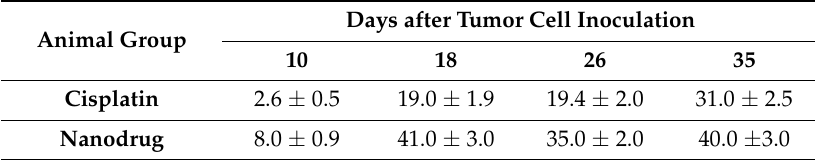
Figure 5. The changes of tumor volume in the standard and nanodrug receiver groups compared to the control group. Statistical significance: * p < 0.05, ** p < 0.01. Table 2. The values of the tumor growth inhibition index (TGII) for cisplatin and nanodrug receiver mice on various days after tumor cell inoculation.